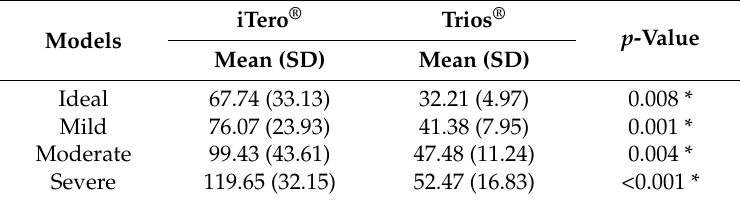
Table 5. Comparison of deviations of the scanned images of the four models from iTero ® and Trios ® (unit: µ m).